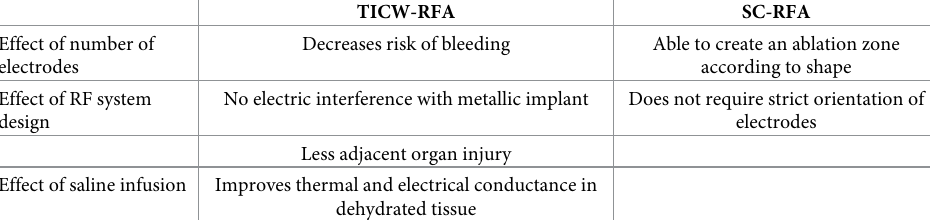
according to shape electrodes